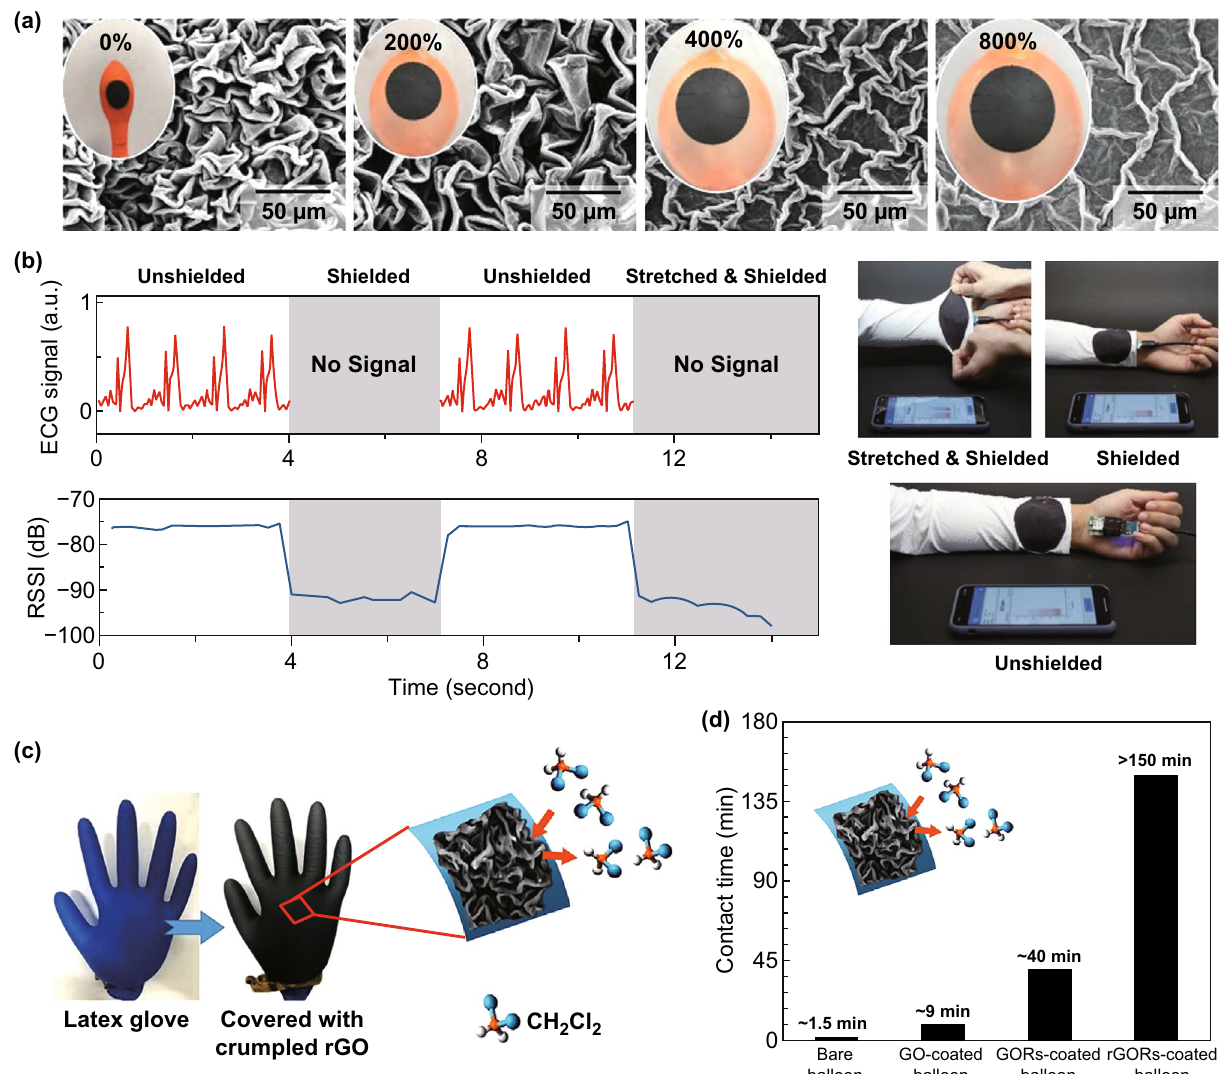
Fig. 16 Highly compressed crumpled films for a , b stretchable electromagnetic shielding and c , d chemical barrier. a SEM images and digital photos of crumpled MXene-SWNT coating under various areal strains. b ECG signal and Bluetooth RSSI received by the smartphone with and without MXene-SWNT shield at its relaxed and stretching states [62]. Copyright 2019 Wiley. c Photos of a latex glove coated with hierarchical rGO crumples for stretchable chemical-protective uniforms. d Superior chemical-protective performance of rGO-coated glove, and no obvious damages are observed even after immersing into dichloromethane over 2.5 h [61]. Copyright 2019 American Chemical